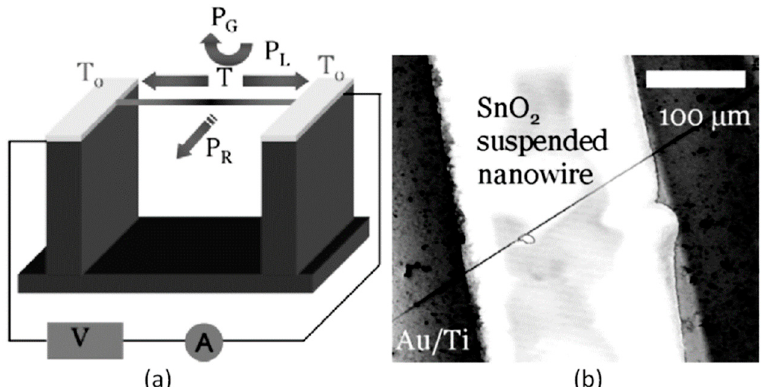
Figure 6. ( a ) The sensor setup and principal thermal losses in the suspended nanowire heated by the Joule heat: P L -losses to the contacts, P G - losses to the ambient gas, and P R -radiation losses; ( b ) SEM image of the suspended SnO 2 chemiresistor. Reproduced with permission from Strelcov et al. [168]. Copyright 2009: American Institute of Physics.